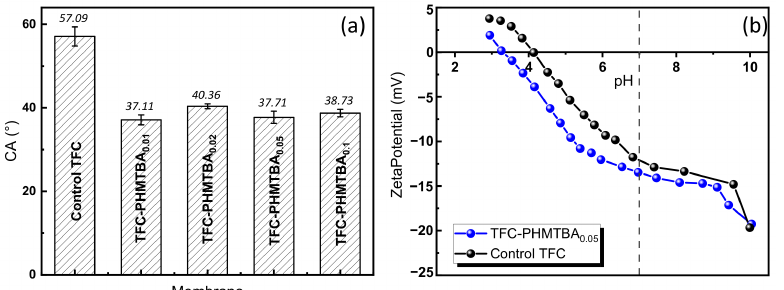
Figure 6. ( a ) WCA of unmodified and PHMTBA − modified membranes and ( b ) zeta potential at different pH values of control TFC and PA − PHMTBA 0.05 membranes.